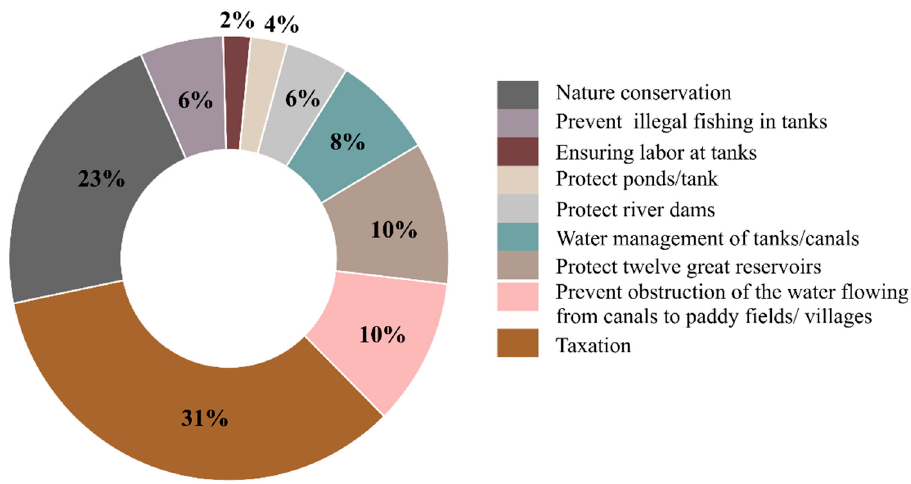
Figure 7. Different categories of official announcements on irrigation recorded in ancient sources.